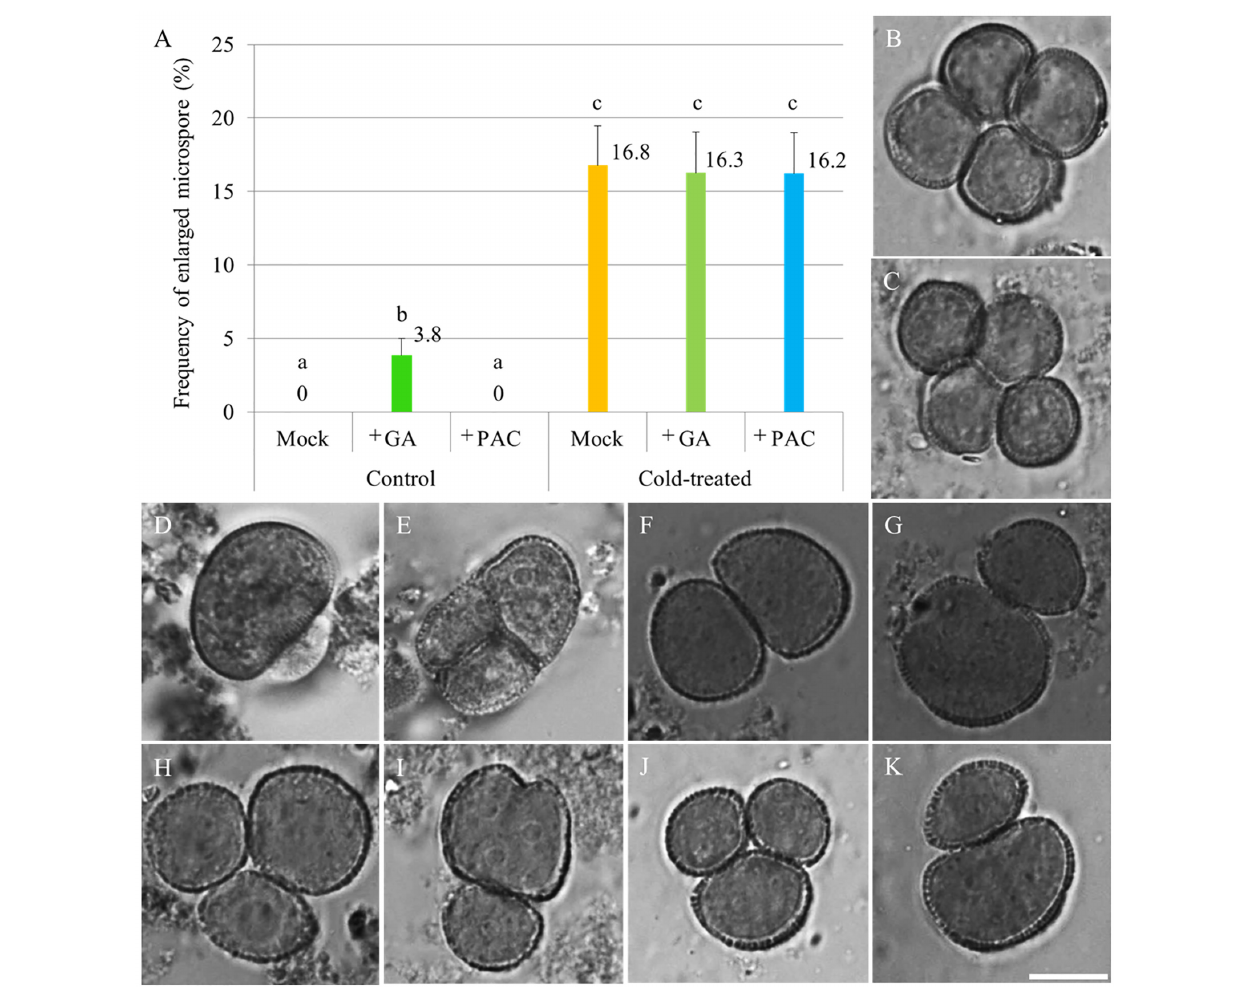
FIGURE 1 | The effect of GA and PAC treatment on cold sensitivity of Arabidopsis male sporogenesis. (A) Histogram showing the frequency of enlarged unicellular microspores in Arabidopsis thaliana plants with combined chemicals and cold treatment. The numbers indicate mean values of the frequency of the enlarged microspores. For each group, 10 biological replicates were performed and more than 500 microspores have been counted. Student’s t -test was used for significance analysis. The qrt1-2 − / − mutant was used for this quantification assay. (B–E) Haploid unicellular microspores in control plants (B) , plants treated with 1 mM PAC (C) , and enlarged unicellular microspores in plants treated with 100 µ M GA 3 (D,E) under normal temperature conditions. (F–K) Enlarged unicellular microspores in flowering plants exposed to a combined treatment of mock and cold (F,G) , GA and cold (H,I) , and PAC and cold (J,K) . Scale bar = 10 µ